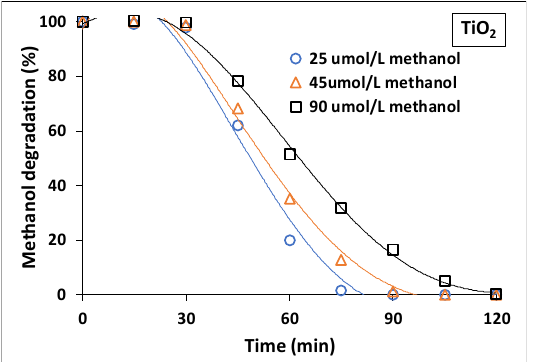
Figure 9. Photocatalytic performance of methanol degradation at different initial concentrations of methanol (25, 45 and 90 µ mol/L) with 2 wt.% Bare-TiO 2 coated on a mesh under near-UV Light. Note: Reported data are for at least three repeats with 8 ± 1% SD.